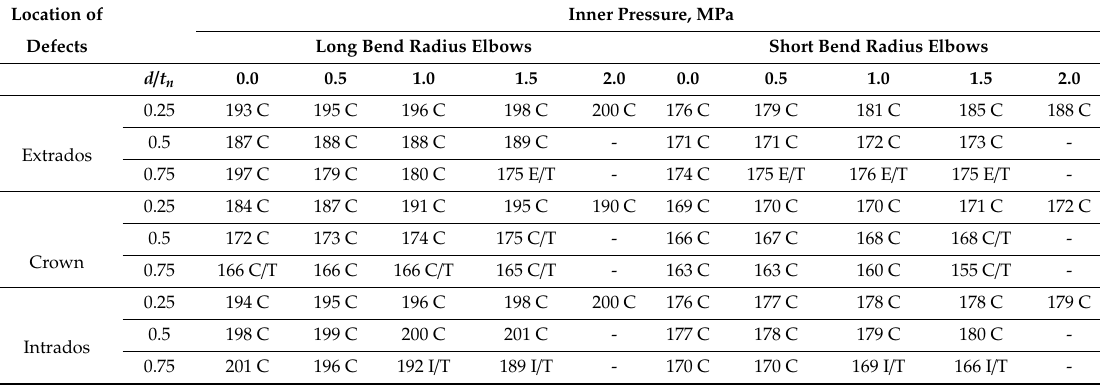
Table 4. Total fatigue life (number of cycles to failure) and location of failure for elbows with artificial